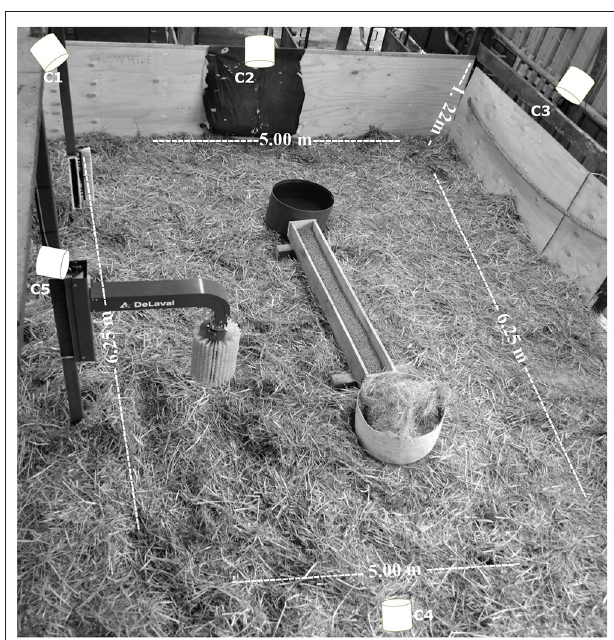
FIGURE 1 | Pen layout, with pen size and cameras location (C1–C5).